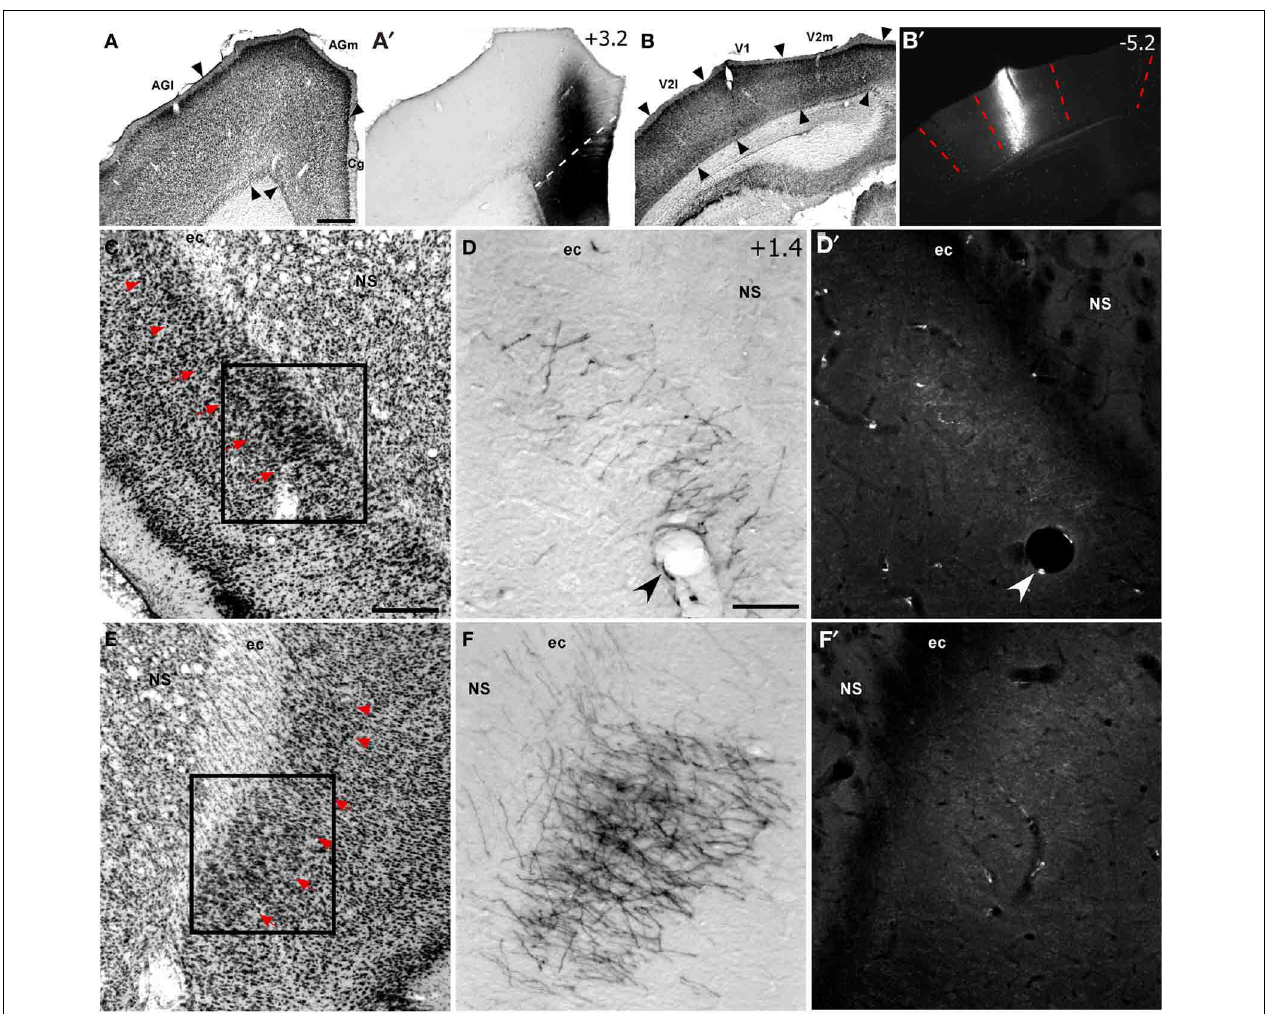
FIGURE 2 | Corticoclaustral projections from FEF and V1 in case TI-15. (A–B’) Left hemisphere injections of BDA in FEF (A,A’) and FluoroRuby (FR) in V1 (B,B’) of the same rat. BDA labeling appeared bilaterally in vCLA (D,F) , but was noticeably denser on the contralateral side (F) . Sparse FR labeling was apparent only in the